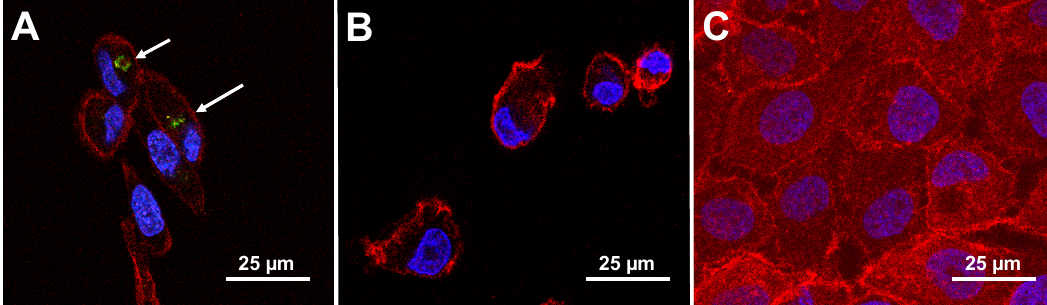
Figure 3. Immunofluorescence analysis of phages towards breast cancer cells in vitro. Phage particles (~10 10 virions) displaying ( A ) a breast cancer cell-specific peptide DSFVNAPE or ( B ) an unrelated peptide VPEGAFSS were incubated with MDA-MB-231 breast cancer cells for 1 h and visualized at 60 × magnification using confocal microscopy. ( C ) Similarly, phage displaying the breast cancer cell-specific peptide DSFVNAPE as incubated with MCF-10A cells for 1 h. Phages were revealed using a rabbit anti-fd IgG primary antibody and an AlexaFluor ® 488-conjugated goat anti-rabbit IgG secondary antibody (green), actin was identified using AlexaFluor ® 546-labeled phalloidin (red) and nuclei were identified by DAPI staining (blue). ( A ) DSFVNAPE phages (identified by white arrows) were found internalized after 1 h and demonstrated perinuclear localization as round spots. Linear phage particles could also be found on the surface of the cells in other time points. ( B ) Phages bearing an unrelated peptide were not found interacting with the cells under the same conditions. ( C ) DSFVNAPE phages were not found interacting with the phenotypically normal breast epithelial cell line, MFC-10A, under the same conditions.